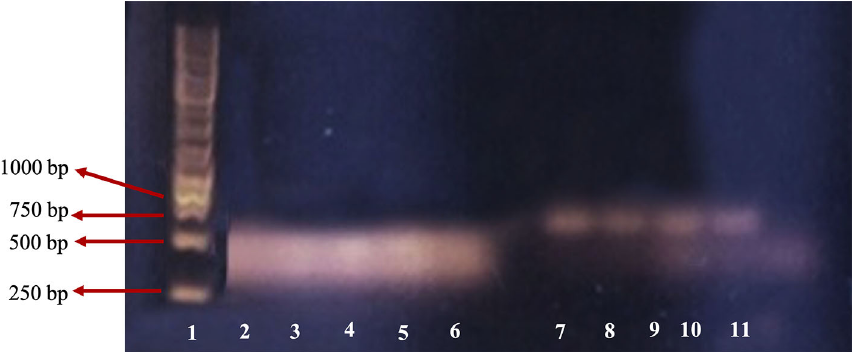
Figure 2. DNA PCR fragment of β -actin and β -tubulin 3 on 1% agarose gel. 1: leaders; 2: β -actin of M4 group; 3: β -actin of M3 group; 4: β -actin of M2 group; 5: β -actin of M1 group; 6: β -actin of control; 7: β -tubulin 3 of M4 group; 8: β -tubulin 3 of M3 group; 9: β -tubulin 3 of M2 group; 10: β -tubulin 3 of M1 group; 11: β -tubulin 3 of negative